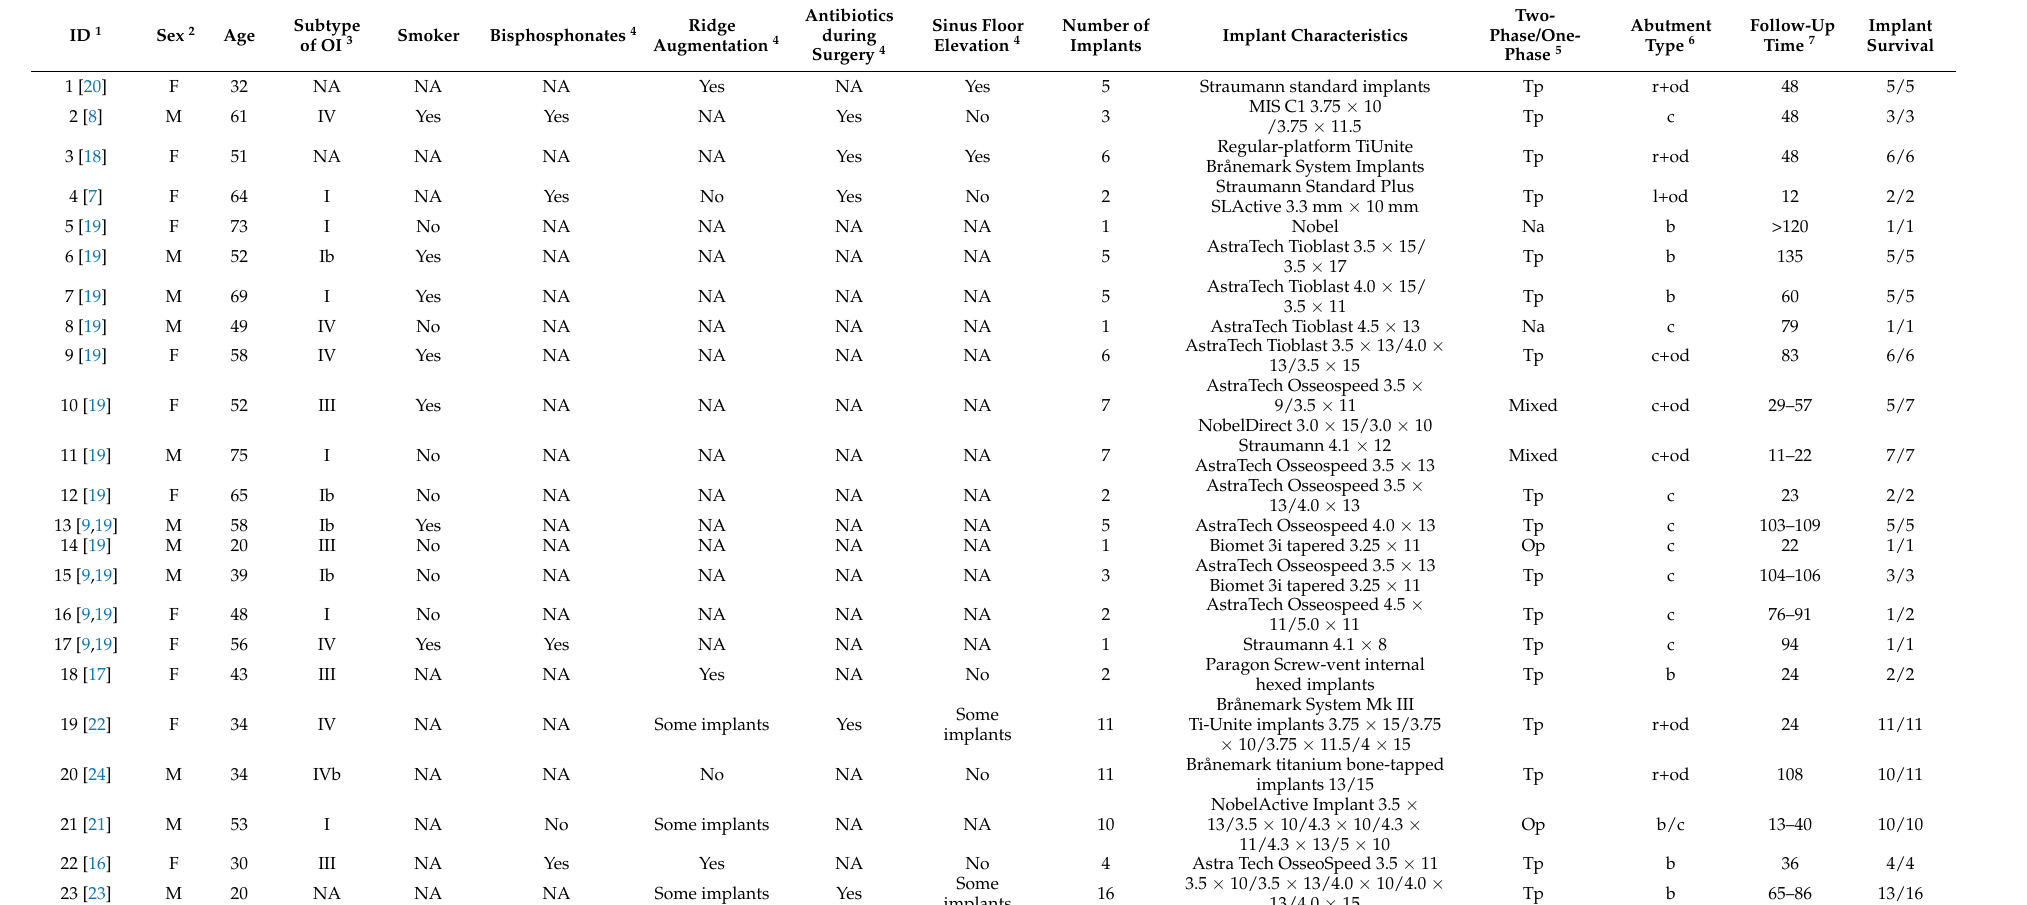
Table 4. Demographic and clinical features of each patient rehabilitated with dental